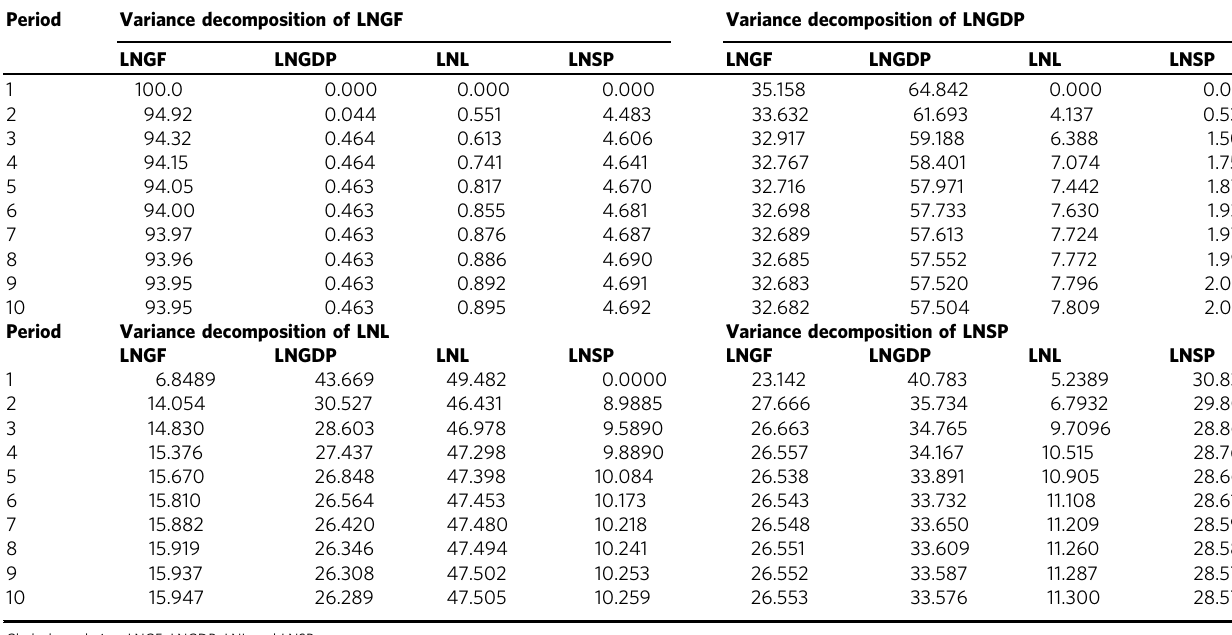
Table 5 Results of variance decomposition of LNGF, LNGDP, LNL, and LNSP.